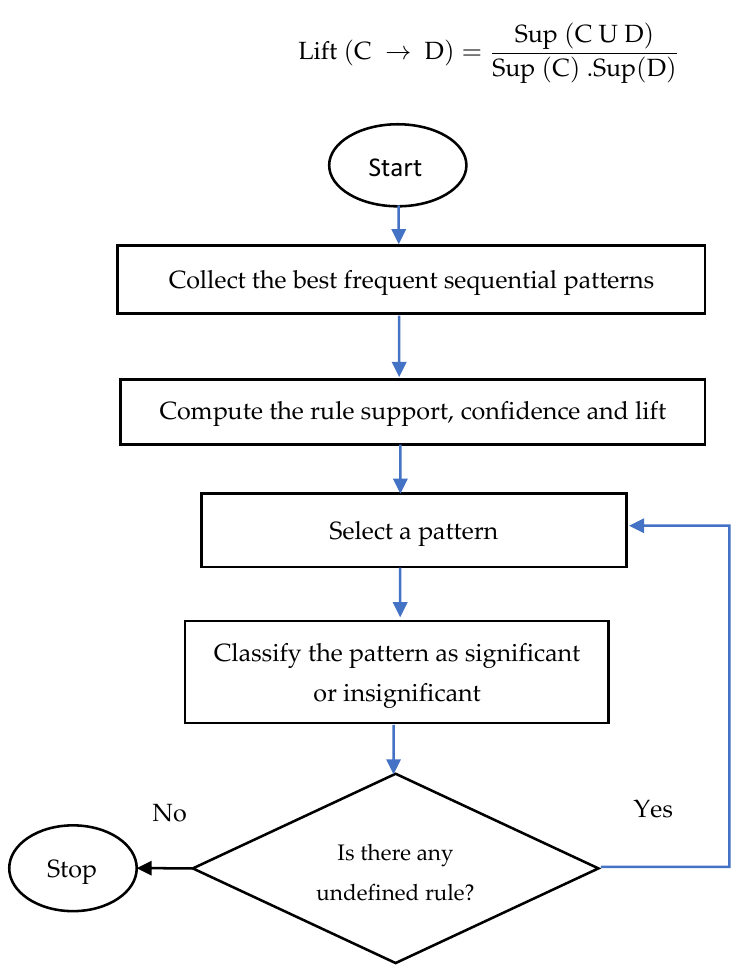
Figure 3. The framework of association rules significance testing.